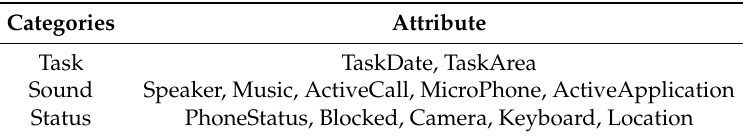
Table 3. Attribute candidates according to their